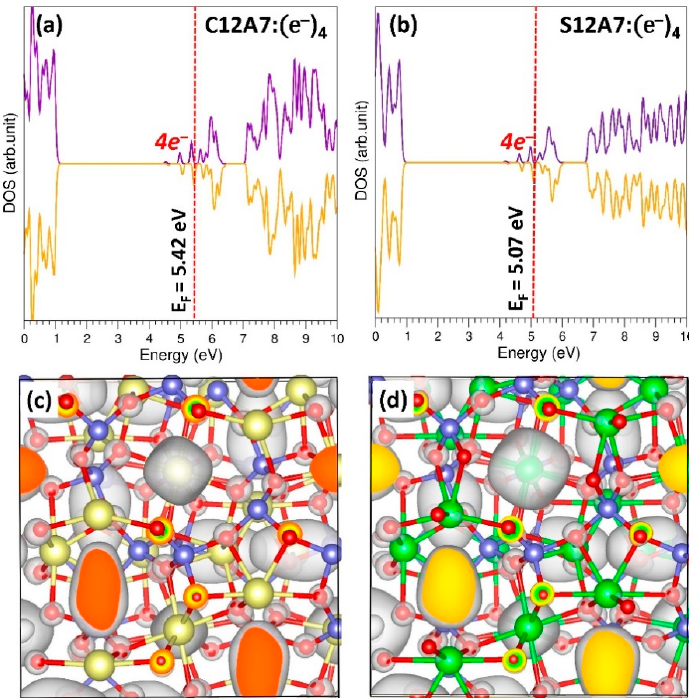
Figure 2. ( a , b ) DOS (density of states) plots calculated for C12A7:(e − ) 4 and S12A7:(e − ) 4 , respectively, and ( c , d ) corresponding charge density plots associated with the extra-framework electrons.